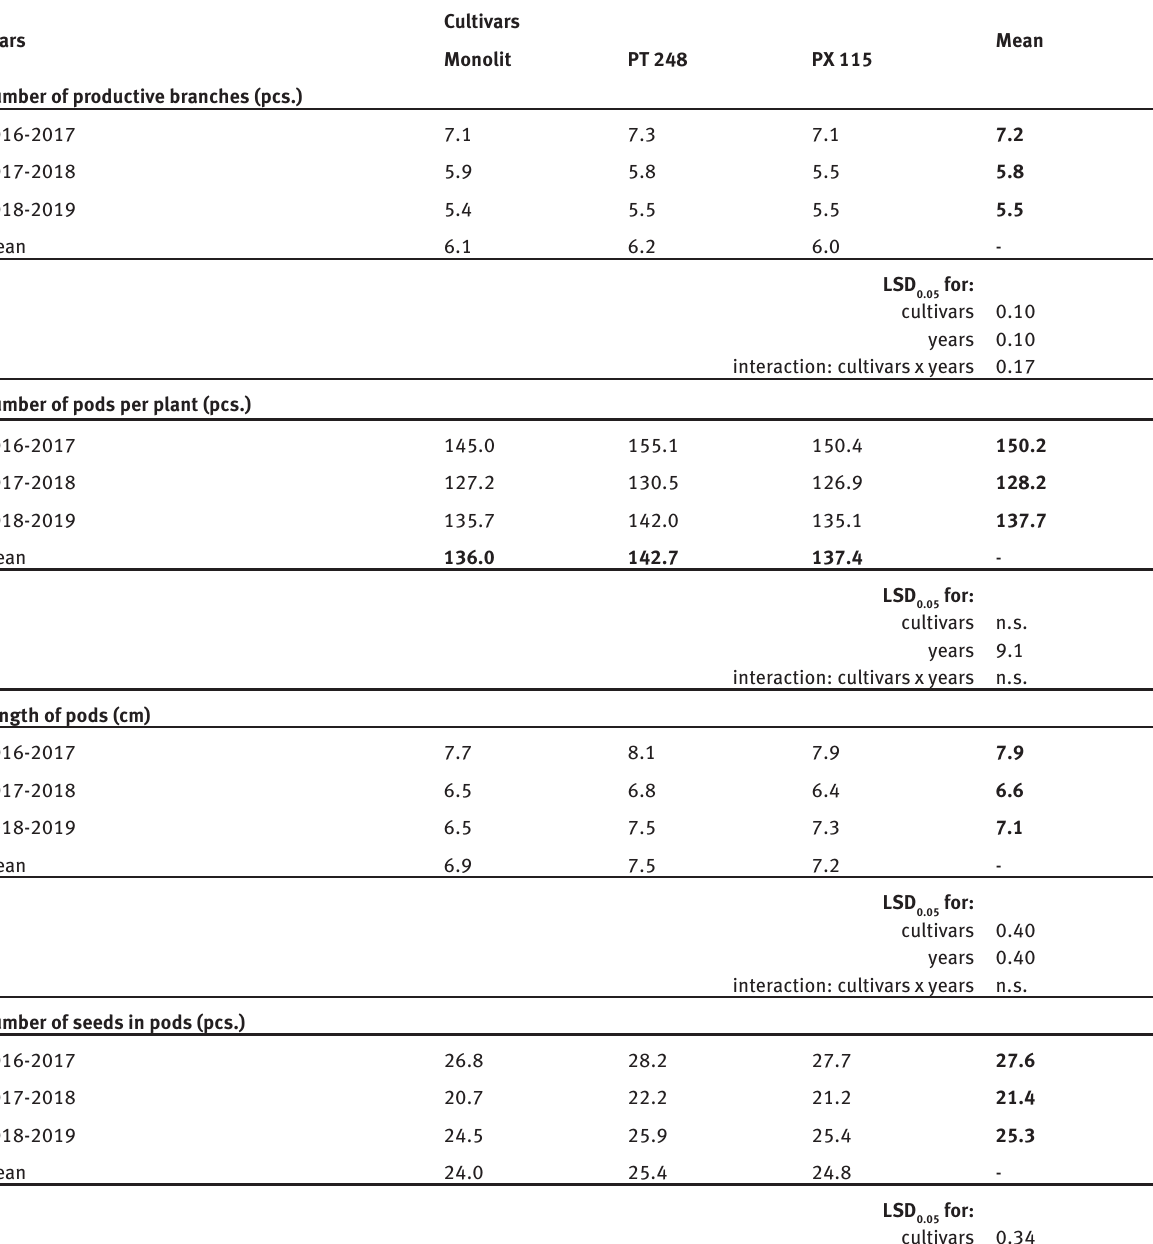
Table 2: Yield components depending on varieties and climatic conditions in the years of research Years Number of productive branches (pcs.)